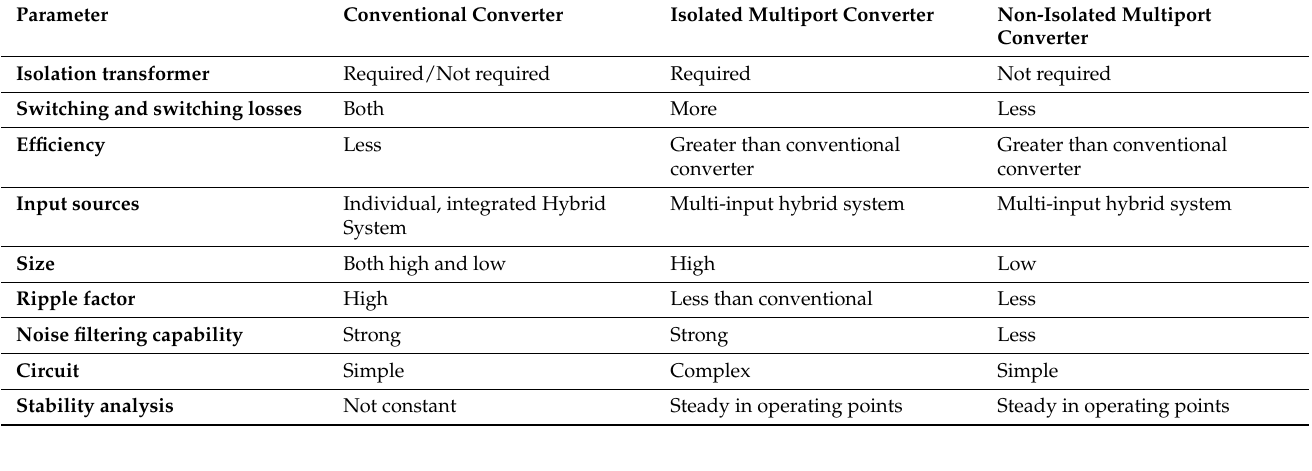
Figure 2. Multiport converters for DC grid integration.